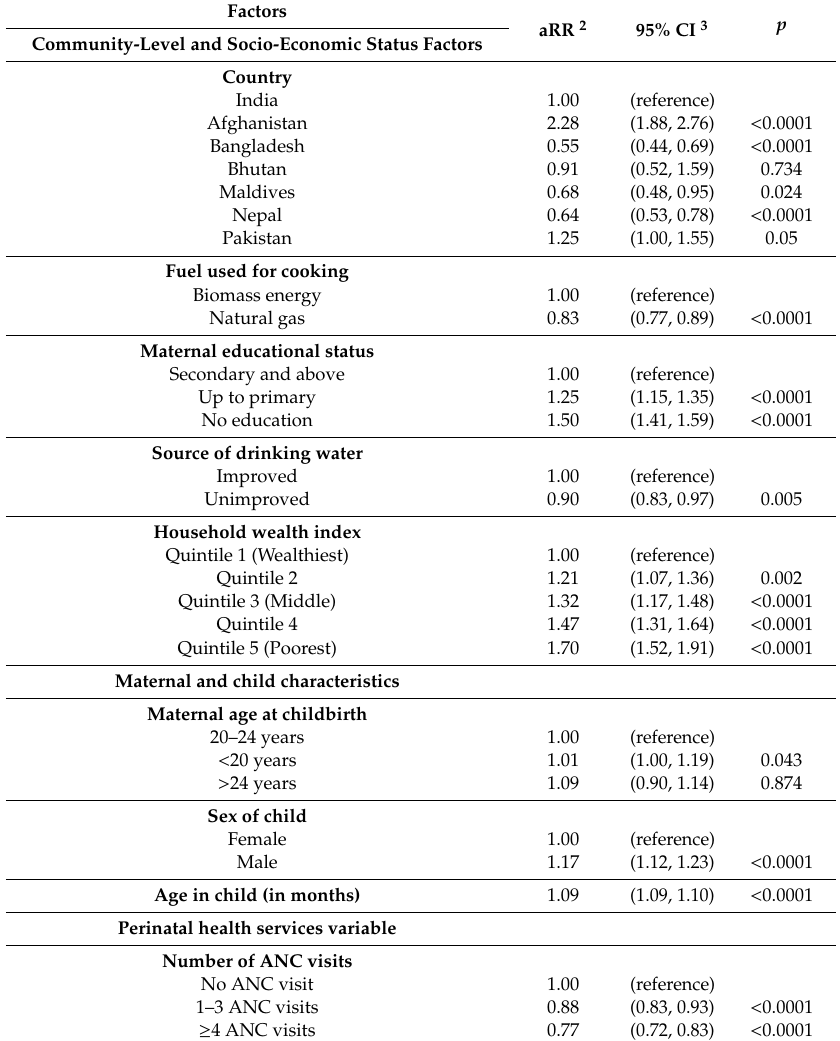
Table 6. Factors associated with severe stunting (LAZ < − 3) in South Asian children < 2 years old (2005–2016): Results of adjusted Poisson regression 1